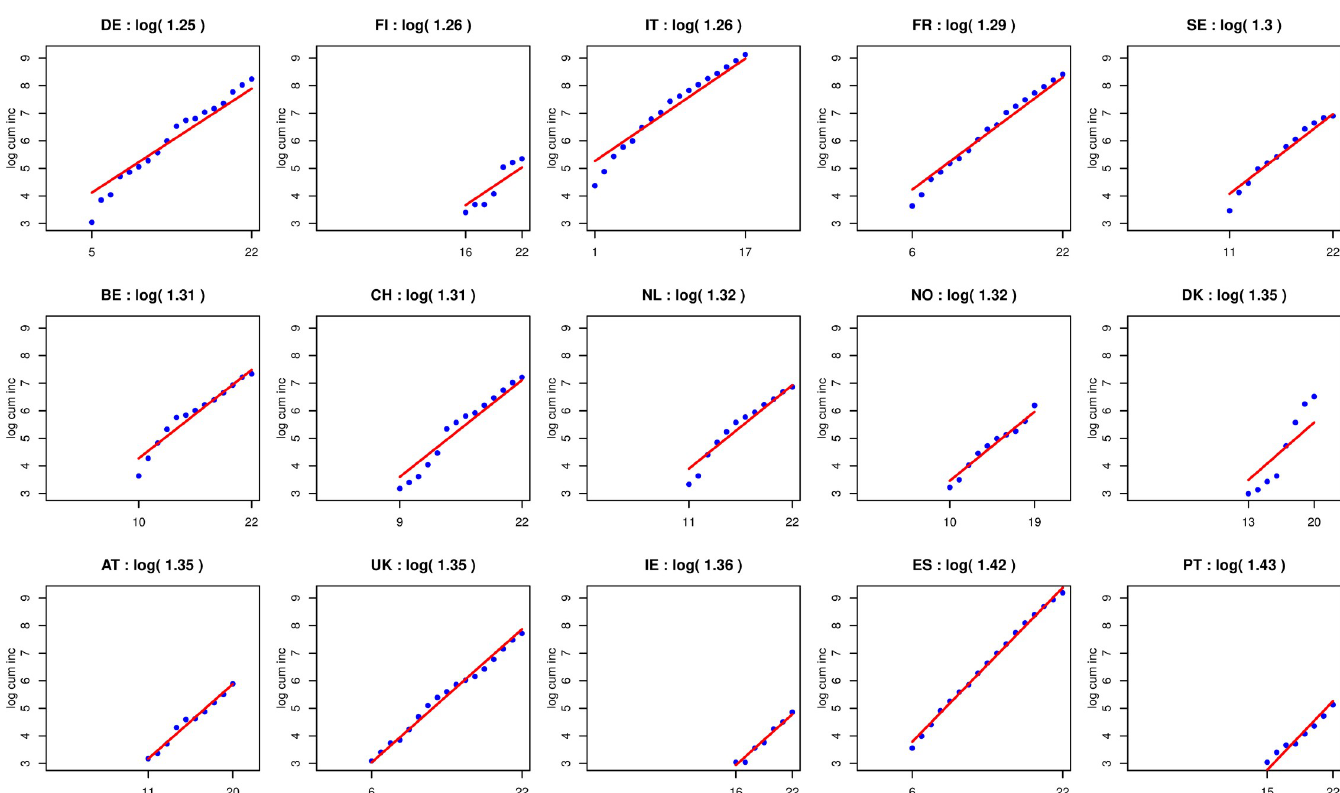
Fig 1. Cumulative incidence of COVID-19 over a selected period in 15 countries in Western Europe (log scale). For each country, a line has been added to the plot, whose intercept represents the center of gravity of the data, and whose slope represents the estimated exponential growth rate of the disease at the start of the outbreak. The selected period was different for each country, ranging from February 23 (day 1) to March 15 (day 22).